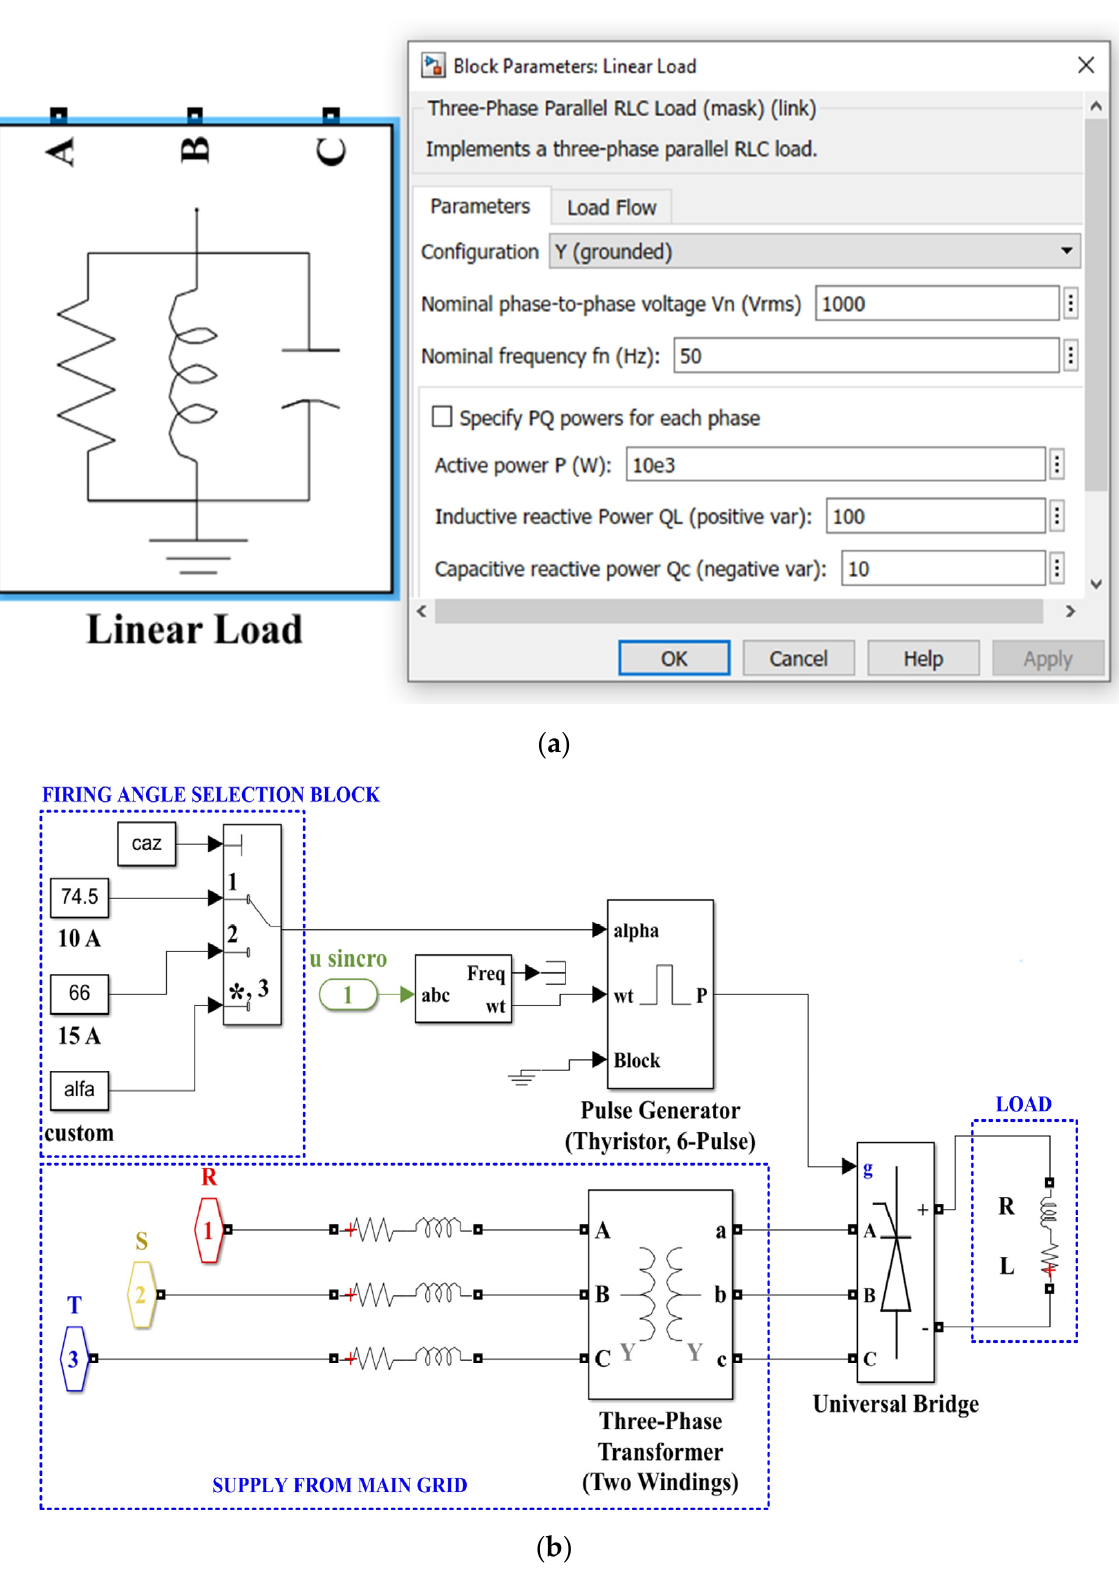
Figure 4. Load types: ( a ) linear load; ( b ) nonlinear load.